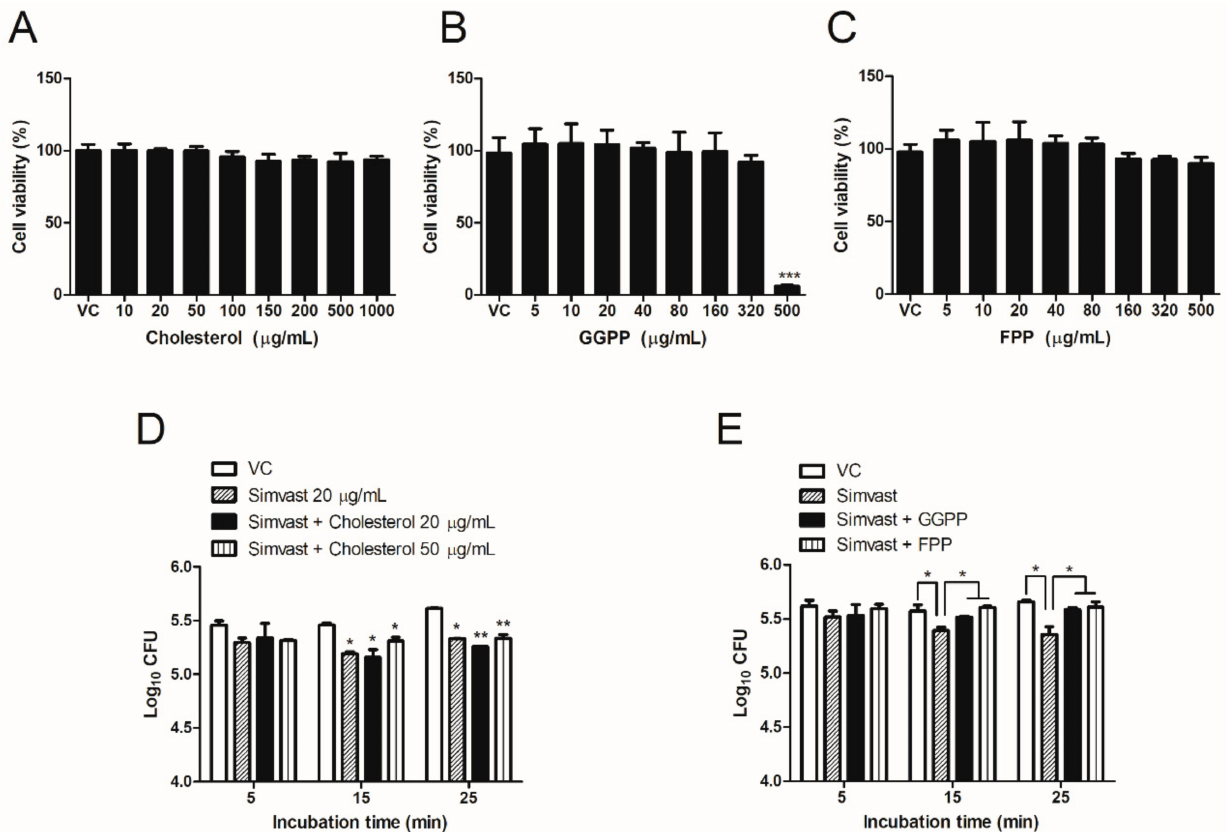
Figure 3. GGPP and FPP, the intermediate products of the mevalonate pathway, affect Brucella internalization in RAW 264.7 cells. The MTT assay was utilized to analyze the cytotoxic effects of cholesterol ( A ), GGPP ( B ), and FPP ( C ) on RAW 264.7 macrophage cells. B. abortus invasion into macrophage cells was evaluated by co-treatment at the same time with simvastatin (20 µ g/mL) and cholesterol (20 and 50 µ g/mL) for 12 h prior to infection ( D ). Cells were pre-treated in the presence of simvastatin (20 µ g/mL) coordinately either with GGPP (80 µ g/mL) or FPP (80 µ g/mL) for 12 h prior to infection followed by the performing of bacterial internalization assay ( E ). The data are represented as the mean ± SD of duplicate samples from at least two independent experiments. Statistically significant differences relative to control group are indicated by an asterisk (* p < 0.05, ** p < 0.01, *** p <